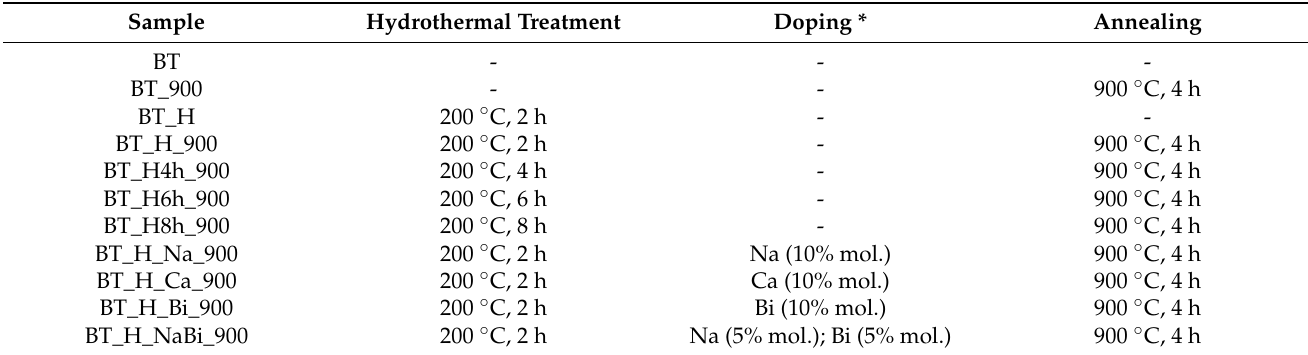
Table 1. Sample labeling and description of production